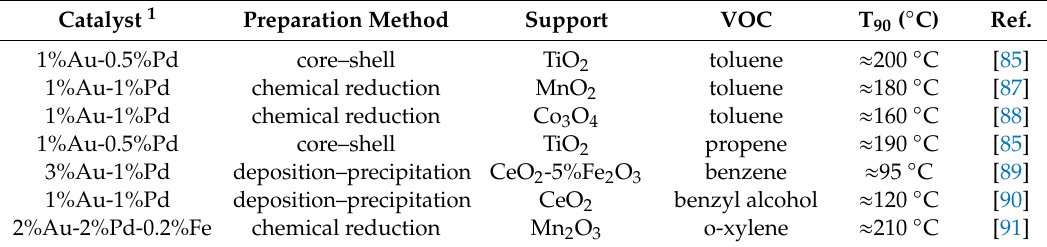
Table 1. Comparison between di ff erent supported Au-Pd bimetallic catalysts in catalytic oxidation of various volatile organic compounds (VOCs).